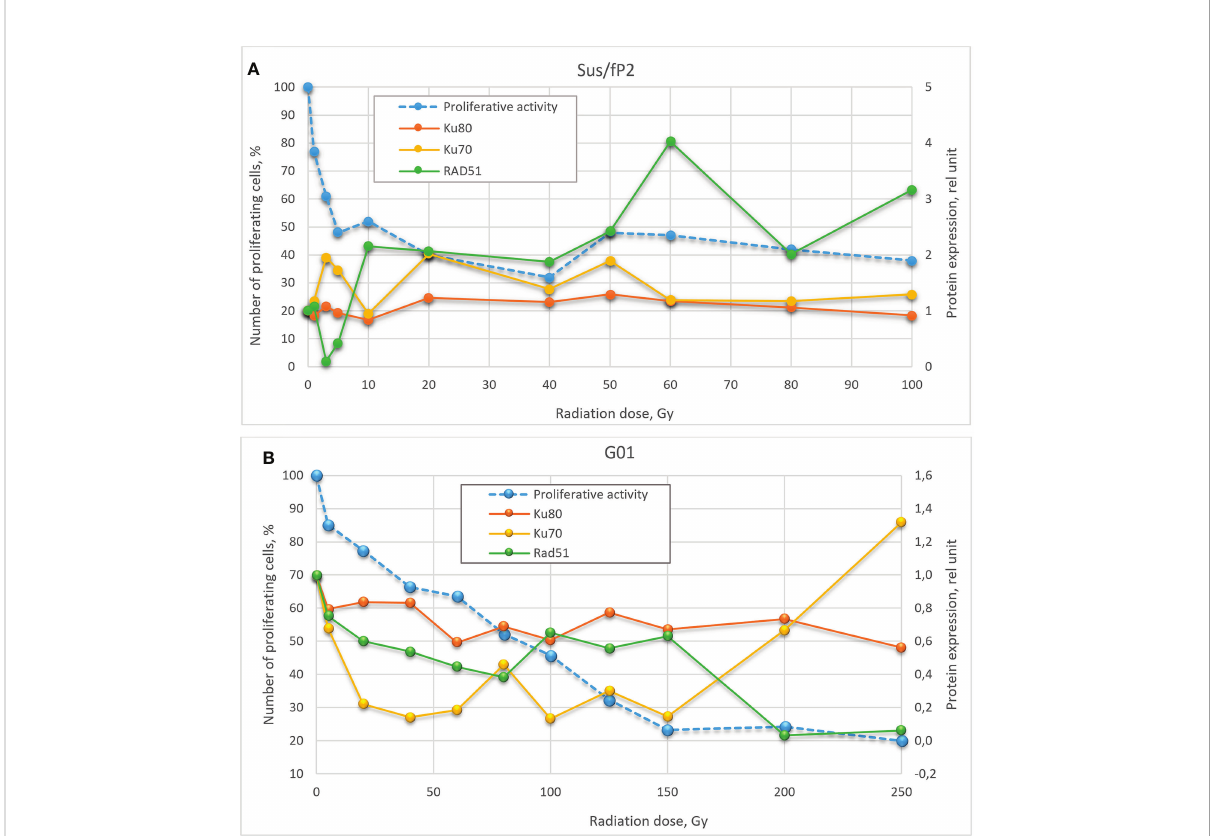
FIGURE 9 Dose-effect relationship between Sus\fP2 (A) and GO1 (B) proliferative activity and expression of RAD51, Ku70, and Ku80